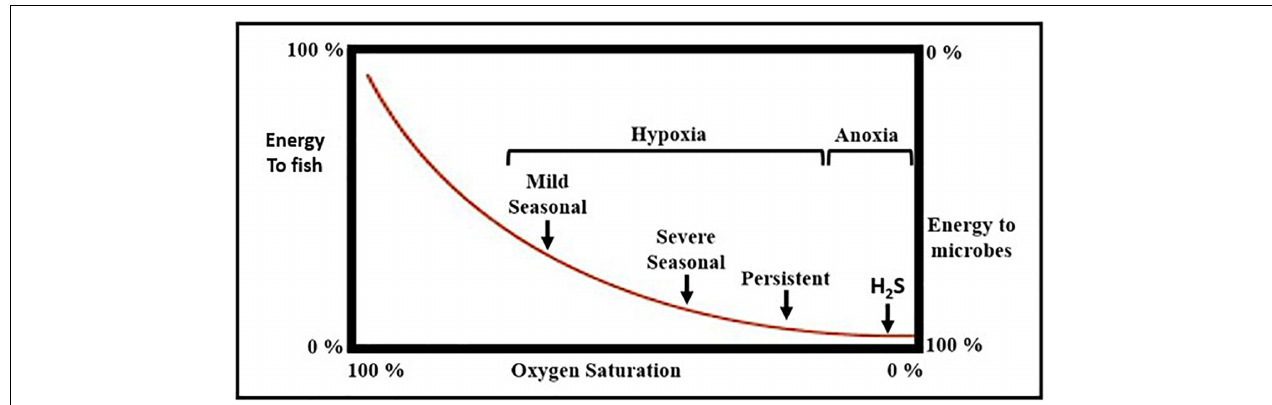
FIGURE 9 | Conceptual diagram of how hypoxia alters energy flow through marine food webs. Typically, 25–75% of macrobenthic carbon biomass is transferred to higher level consumers (e.g., fish populations) when oxygen levels are sufficiently high to support aerobic metazoan animal populations. As oxygen levels decline, higher-level predation decreases and the proportion of benthic energy transferred to microbes increases until microbes process all benthic energy under anoxic conditions with hydrogen sulfide (H 2 S) production (adapted from Diaz and Rosenberg, 2008).